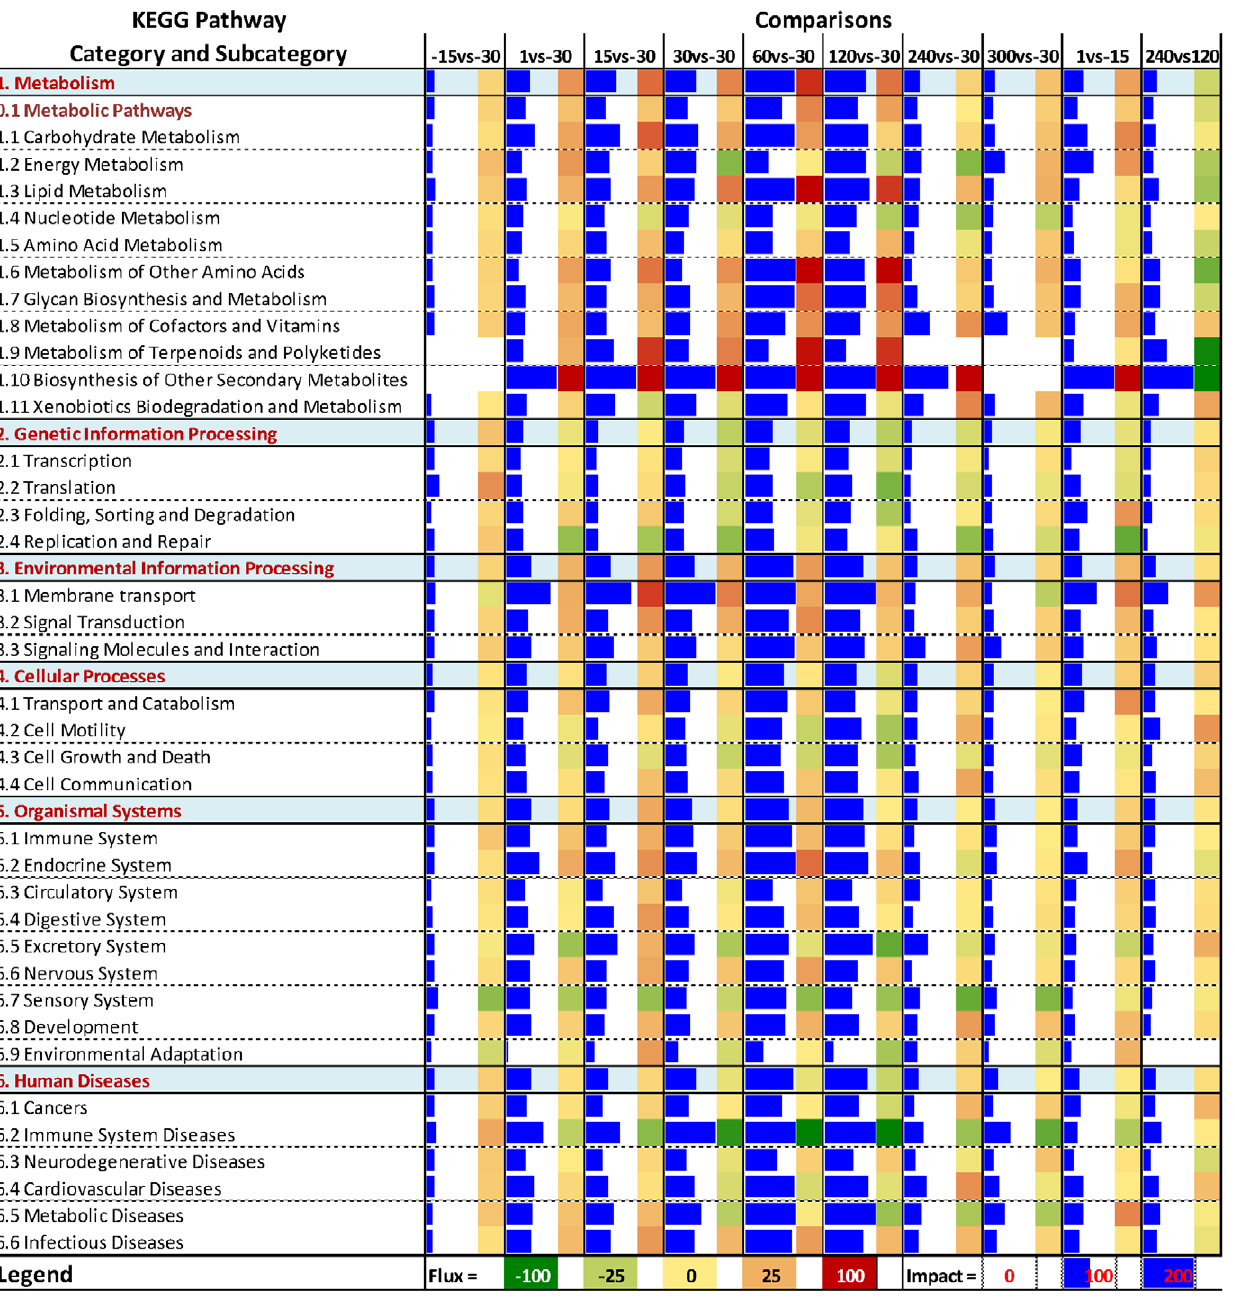
Figure 2. Overall view of the DIA results of the KEGG pathways with main categories and subcategories as provided by KEGG (http:// www.genome.jp/kegg/pathway.html). Reported are all times comparedwith 2 30 d, and the twoconsecutive times (1 vs. 2 15 d and240 vs. 120 d) with the largest number of differentially expressed genes and overall impact on pathways. Blue horizontal bars denote the impact and the square on their right denote the direction of the impact (red=activation; green=inhibition). See companion paper for interpretation of the DIA output.